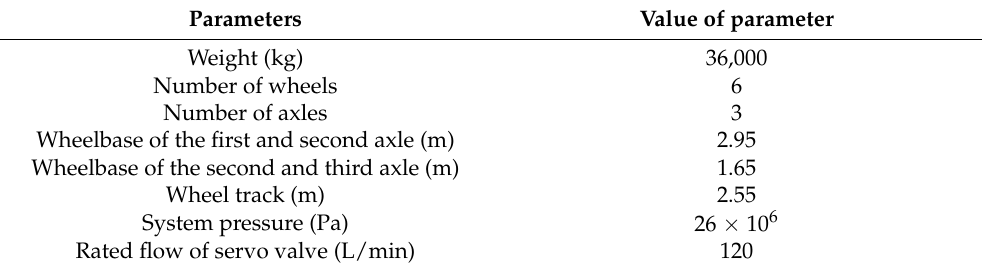
Table 6. Main parameters of emergency rescue vehicles.